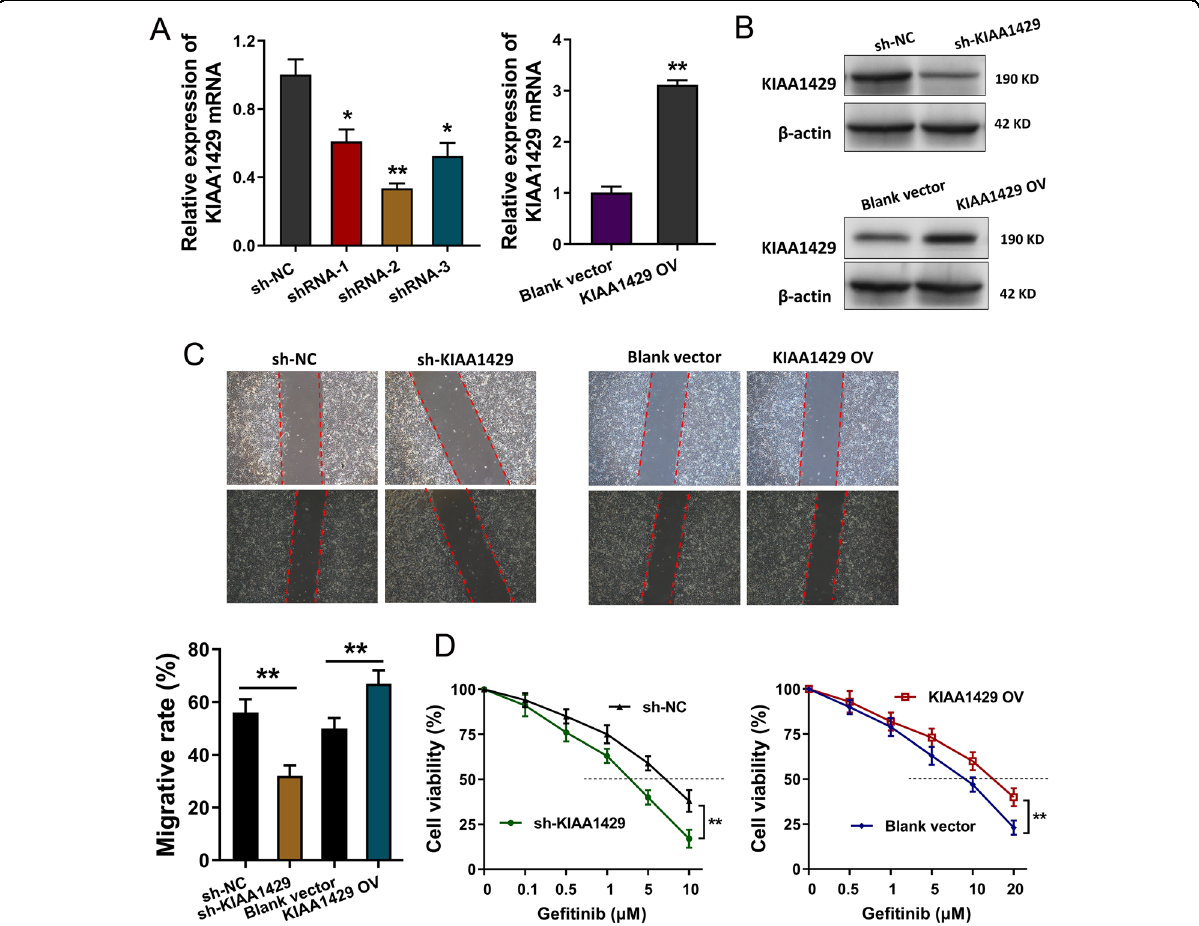
Fig. 2 KIAA1429 promoted the proliferation and ge fi tinib resistance of NSCLC cells. A Short-hairpin RNA (shRNA) and overexpression plasmids were transfected in ge fi tinib-resistant NSCLC cells (PC9-GR) to construct the silencing and overexpression of KIAA1429. RT-qPCR was performed to detect KIAA1429 mRNA. B Western blot analysis detected the KIAA1429 protein level after silencing or overexpression plasmid transfection. C Wound-healing analysis detected the migrative ability of PC9-GR cells with KIAA1429 silencing or overexpression. D Ge fi tinib-resistant analysis was performed to detect the IC 50 value (ge fi tinib concentration causing 50% absorbance decreasing). Bar graphs indicate the means ± SD. * P < 0.05, ** P <